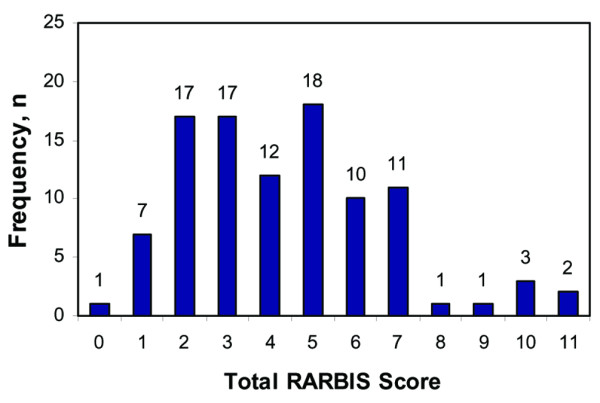
Frequency distribution of the rheumatoid arthritis medical records-based index of severity (RARBIS).